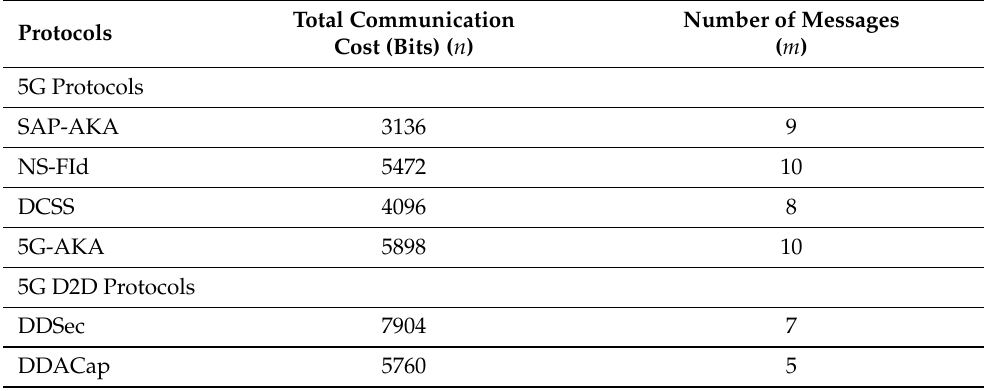
Table 9. Communicational Cost of the Protocols based on Simulation